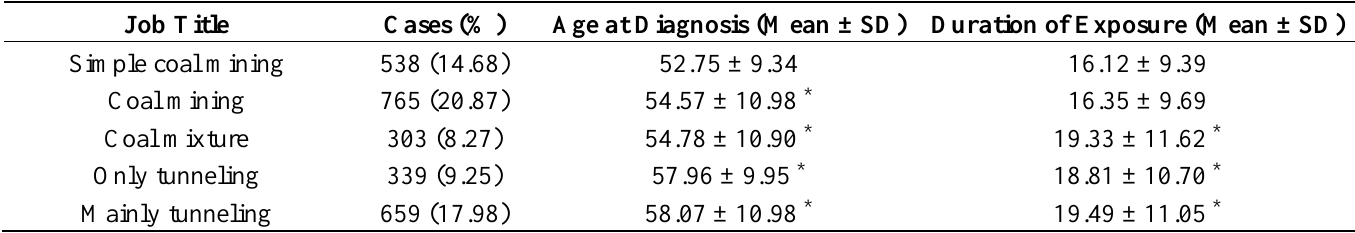
Table 3. Duration of exposure and age at diagnosis by job title.